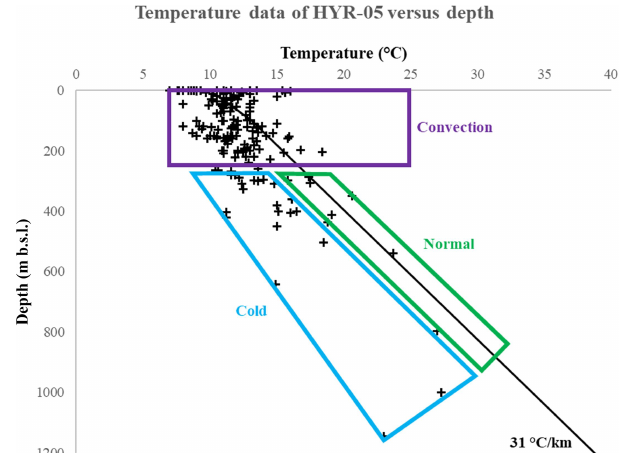
Figure 4. Temperature data of HYR-05 plotted against depth. Sim- ilarly to HYR-03 (Fig. 3) the majority of data from HYR-05 are also characterized by convection and/or follow the typical Hessian geothermal gradient. However, as opposed to HYR-03, neither hot nor very hot groundwater clusters are apparent. Instead, HYR-05 shows a data cluster of cold groundwaters with temperatures below the typical Hessian geothermal gradient. Note that the field convec- tion has been constrained rather arbitrarily and is not based on firm scientific